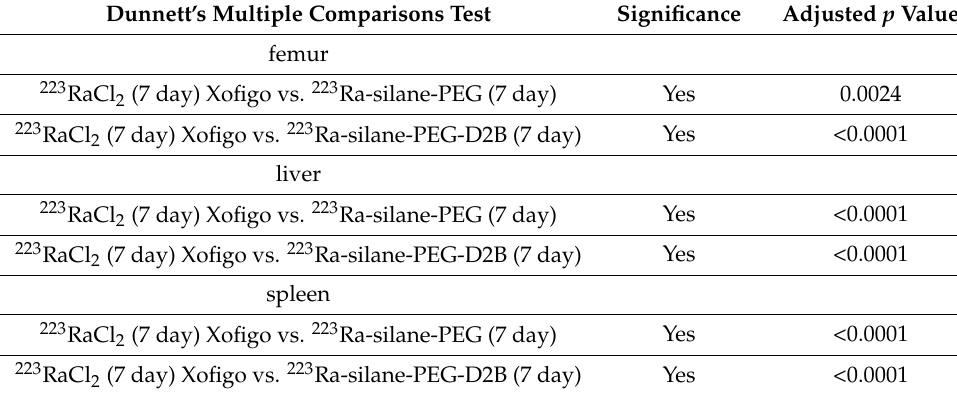
Figure A2. Comparative analysis of biodistribution of 223 Ra-silane-PEG-D2B and 223 Ra-silane-PEG with biodistribution of 223 RaCl 2 (Xofigo) on 7th day. BALB/c mice (weight: 19.1–23.6 g; age 6 week) were exposed to a single intravenous dose of 223 RaCl2 of ~25 µL (20 g body weight with solution activity at 500 kBq/mL on day 0). Table A2. Statistical analysis of the comparison of biodistribution of 223 RaCl 2 , 223 Ra-silane-PEG and 223 Ra-silane-PEG-D2B in